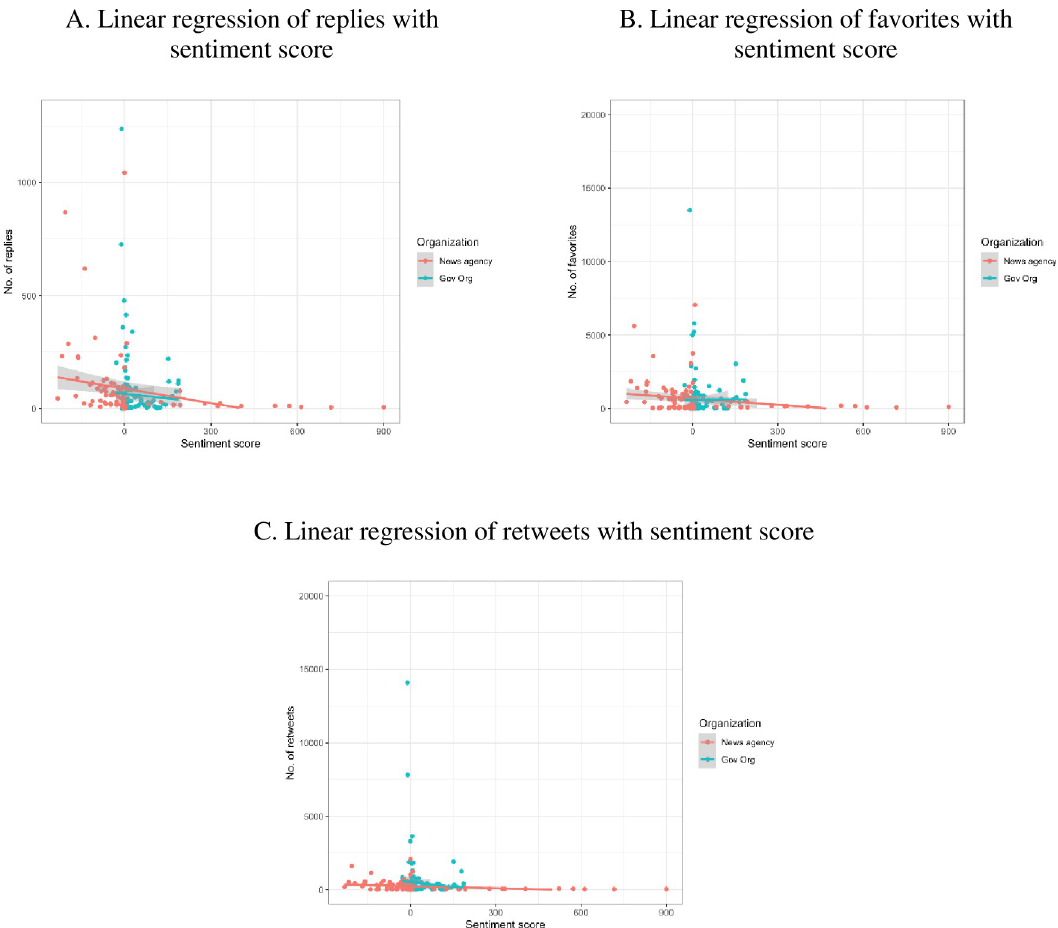
Fig 7. Stability of the differential effect of treatment (linear regression of sentiment score on multiple responses). Gov Org: Government organization.